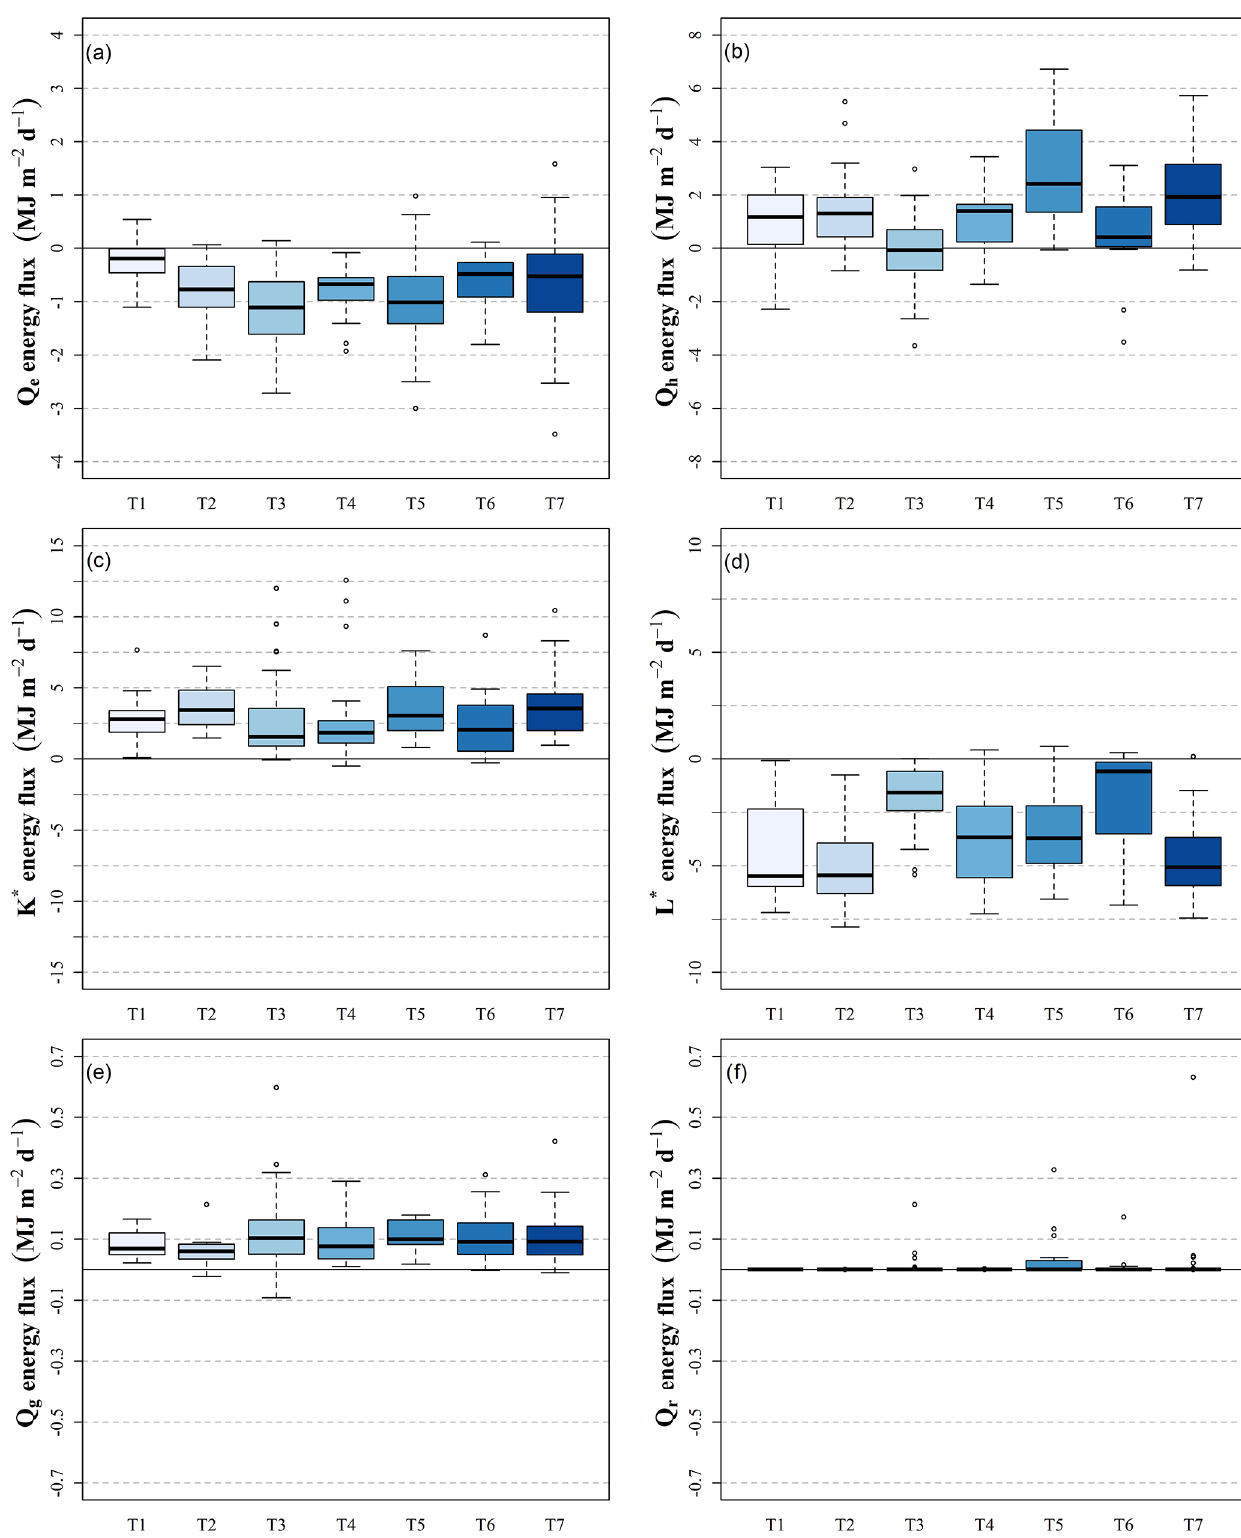
Figure 5. Box plots of daily snowpack latent heat (a) , sensible heat (b) , net shortwave radiation (c) , net longwave radiation (d) , ground heat flux (e) , and liquid precipitation (f) energy fluxes for each synoptic type during the 2016 and 2017